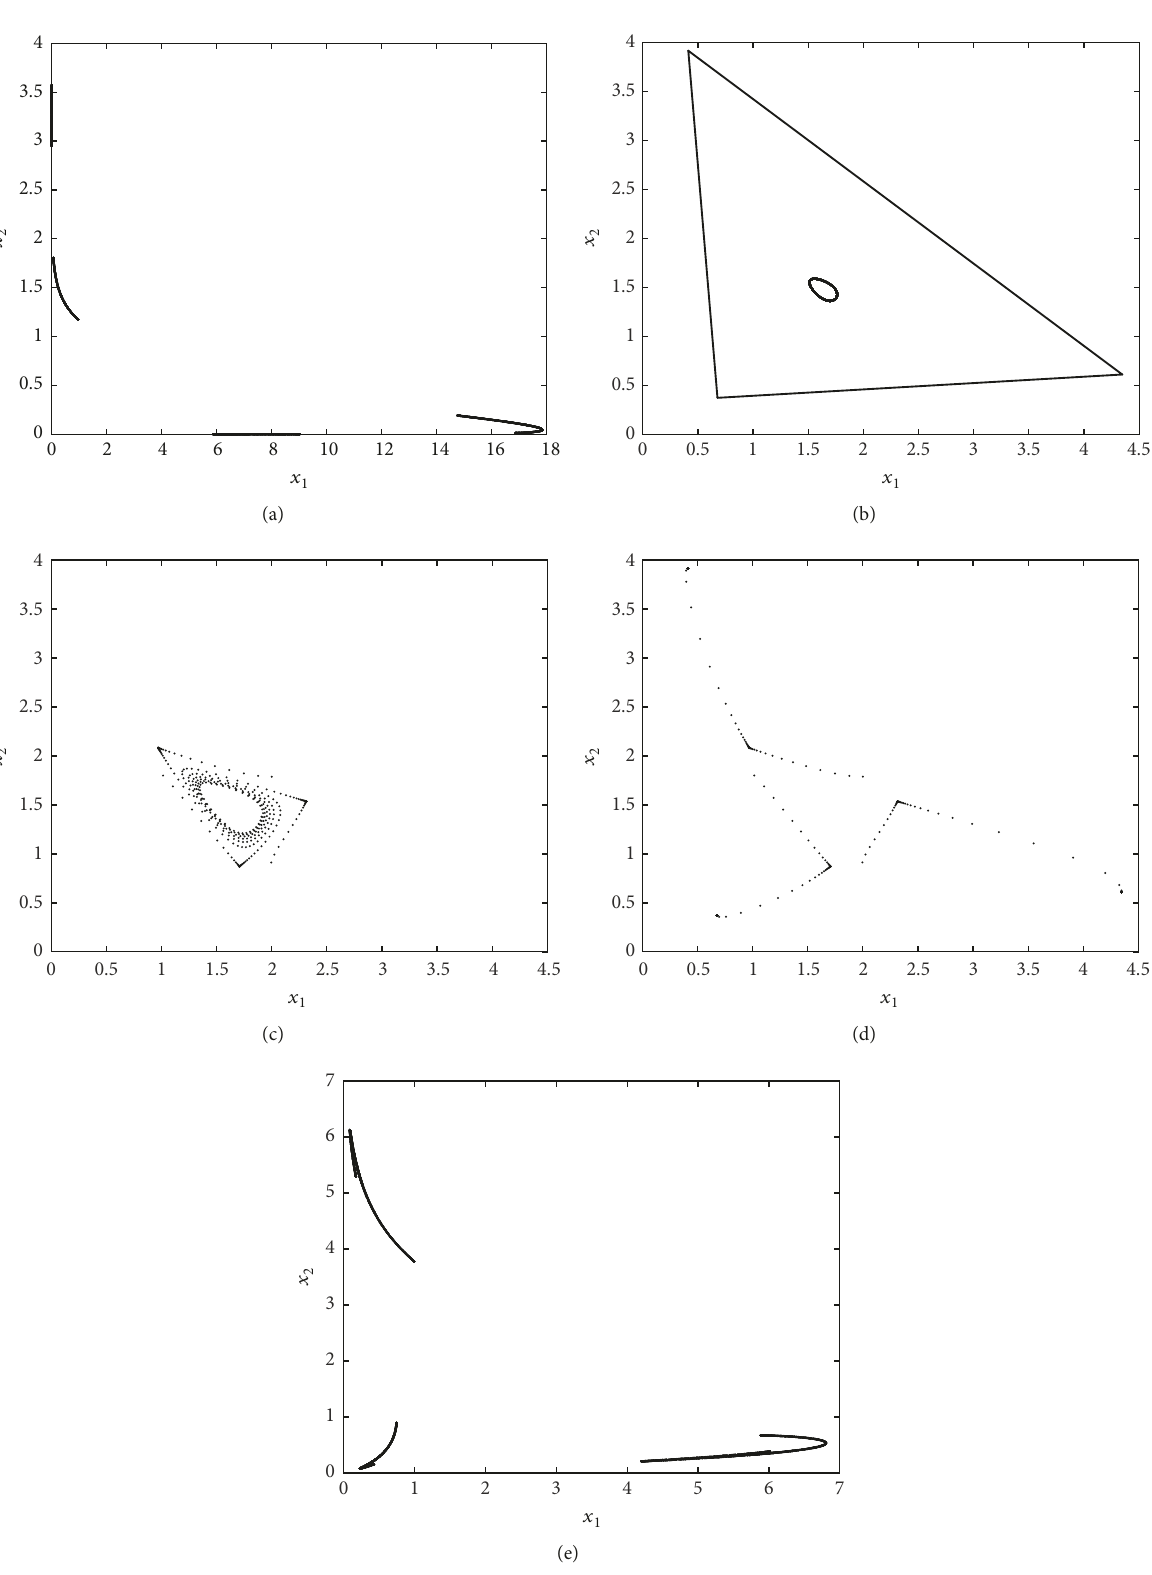
Figure 2: (a) Dynamics generated by map (15). Parameter values (𝑃,𝐹) = (0.2, 58.5) . (b) Coexisting attractors. (𝑃,𝐹) = (0.9, 11.83) . (c) Convergence towards the invariant curve. (𝑃,𝐹) = (0.9, 11.83) and (𝑥 1,0 ,𝑥 2,0 ) = (2.0, 1.78825) . (d) Convergence towards the 3 -cycle. (𝑃, 𝐹) = (0.9, 11.83) and (𝑥 , 𝑥 ) = (2.0,1.78830) . (e) Chaotic dynamics generated by map (15). (𝑃,𝐹) = (0.9, 18.5) 1,0 2,0